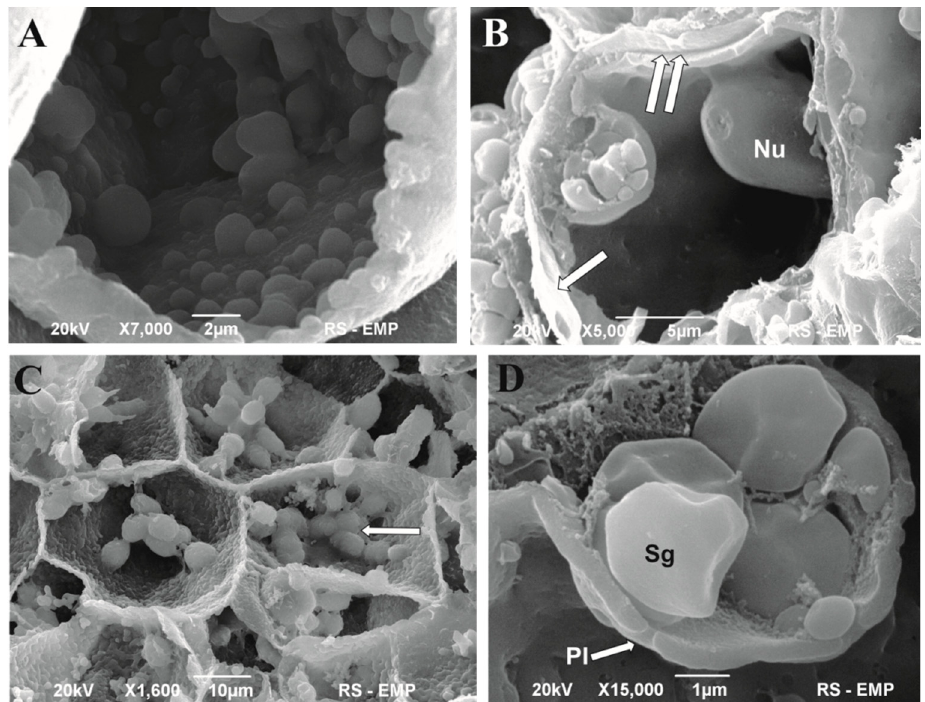
Figure 4. SEM image of the intracellular structure of cells of the Cyathea smithii cell aggregates. ( A ) An overview of the cell interior showing numerous organelles along the cell wall. ( B ) Cell wall (single arrow) and middle lamella (two arrows). ( C ) Globular cytoplasmic organelles (peroxisomes) associated with the cell wall or narrow bands of the cytoplasm. ( D ) Complex of starch grains surrounded by the cell wall with evident plasmodesmata. Pl—plasmodesmata; Nu—nucleus; Sg— starch grains.